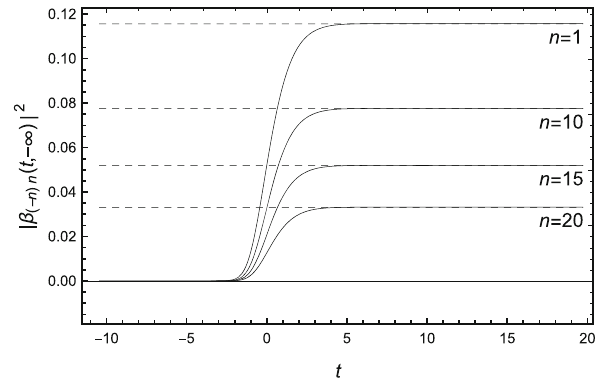
Fig. 2 Timeevolutionof | β ( − n ) n ( t , −∞ ) | 2 asobtainedfromnumerical computation (solid lines), and asymptotic values | β ( − n ) n ( ∞ , −∞ ) | 2 as given in [29] (dashed lines). The mass of the field is m = 0 . 1, periodic boundary conditions are imposed for a length of L = 1000, and the parameters of a (η) are A = 2 . 5, B = 1 . 5 and ρ =